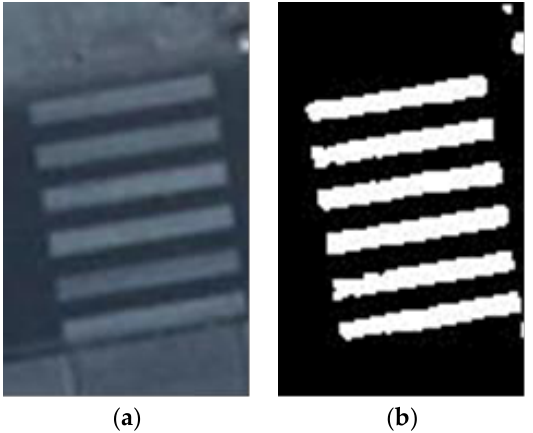
Figure 10. Example of image preprocessing. ( a ) is the original image of zebra crossing object; and ( b ) is the preprocessed image.